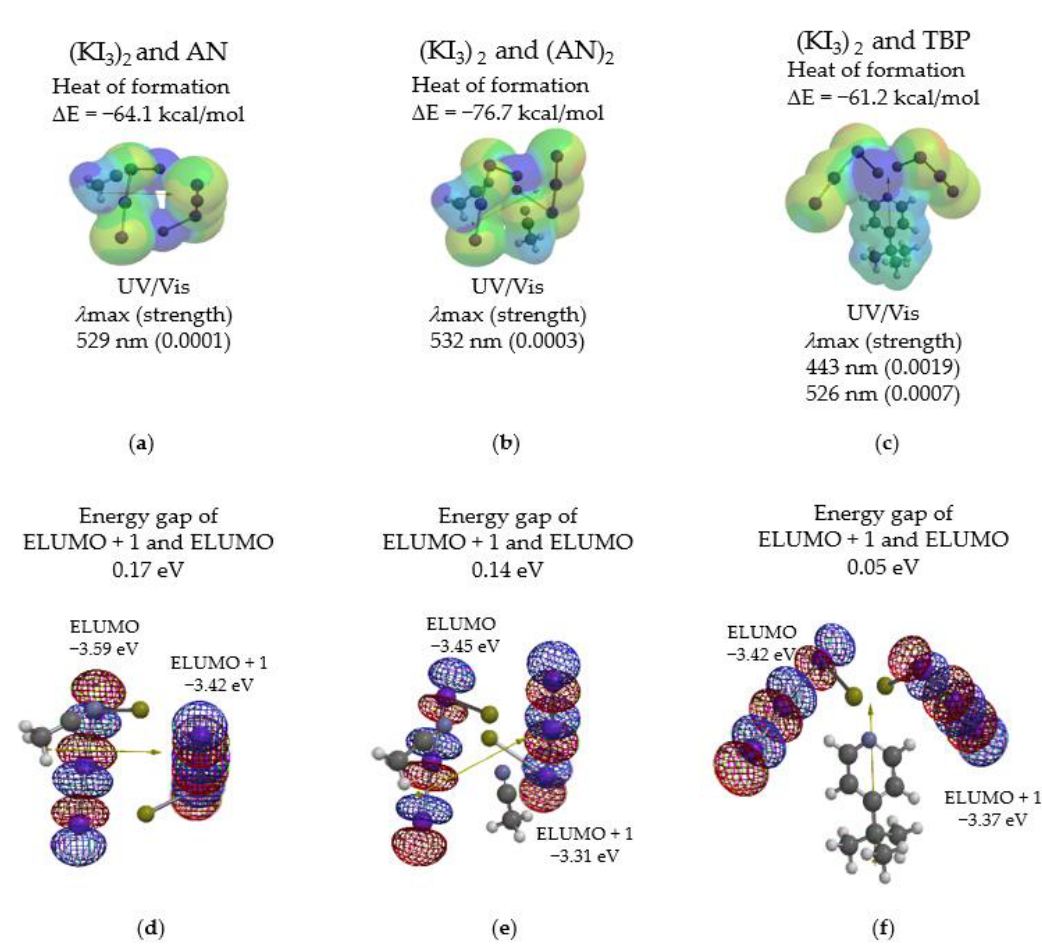
Figure 4. Equilibrium geometry of van der Waals aggregates, heat of formation and energy gap of ELUMO + 1 and ELUMO: ( a ) (KI 3 ) 2 and AN; ∆E = −64.1 kcal/mol ( b ) (KI 3 ) 2 and (AN) 2 ; ( c ) (KI 3 ) 2 and 4-tert-butylpyridine (TBP); ( d ) LUMO configuration of (KI 3 ) 2 and AN; ( e ) LUMO configuration of (KI 3 ) 2 and (AN) 2 ; ( f ) LUMO configuration of (KI 3 ) 2 and 4-tert-butylpyridine (TBP) .